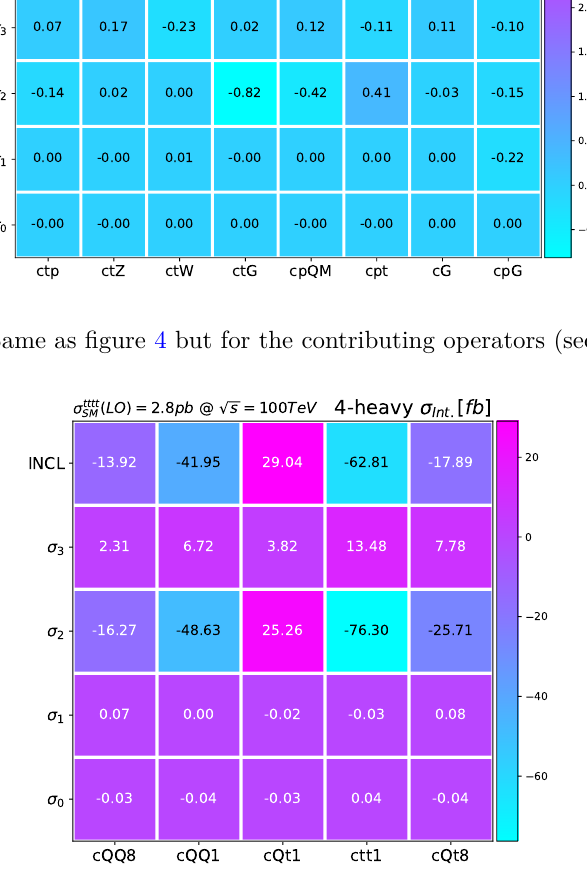
√ s = 100 TeV is presented for reference.